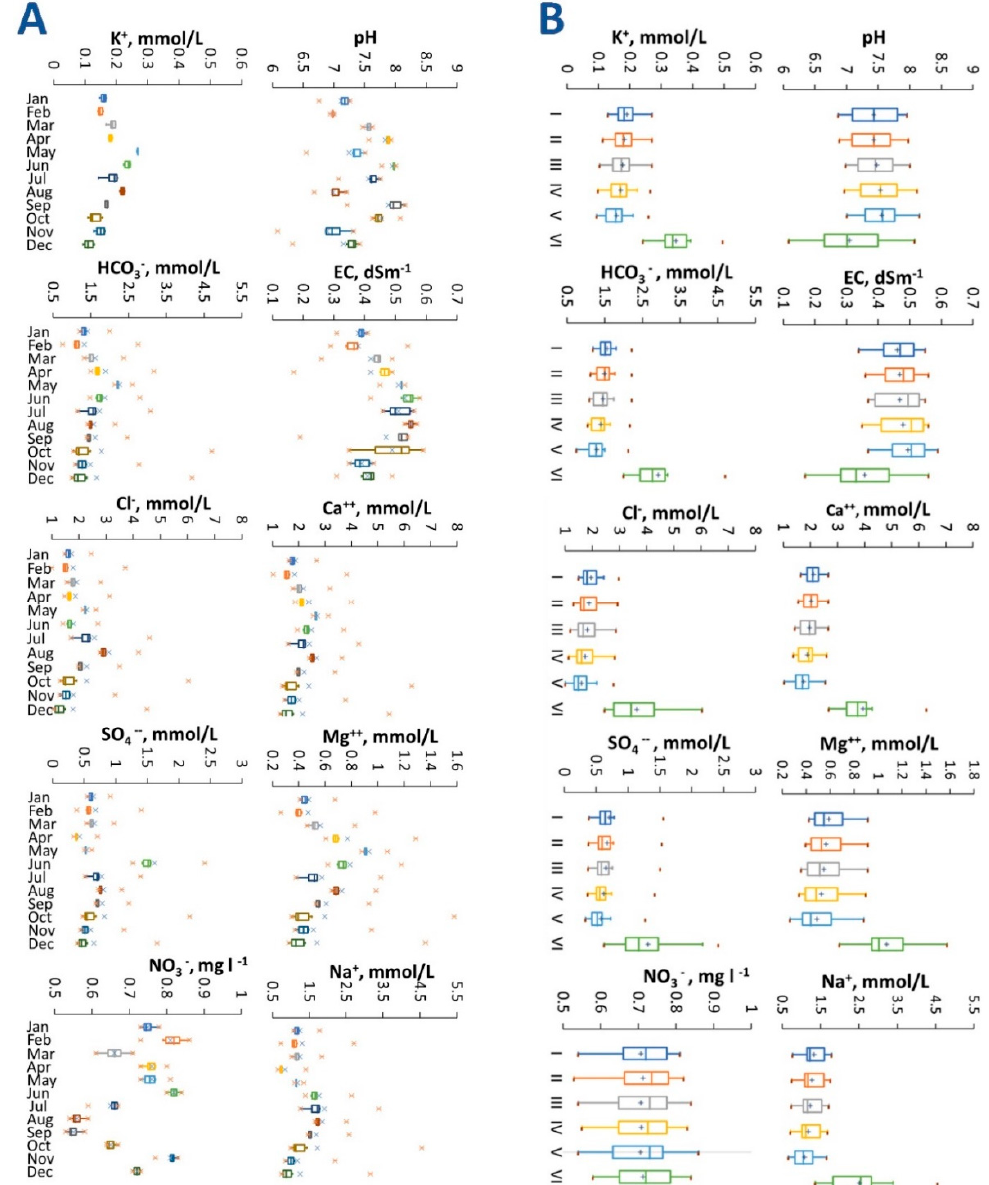
Figure 5. Spatiotemporal analysis of the chemical water composition—monthly ( A ) and at each sampling site ( B